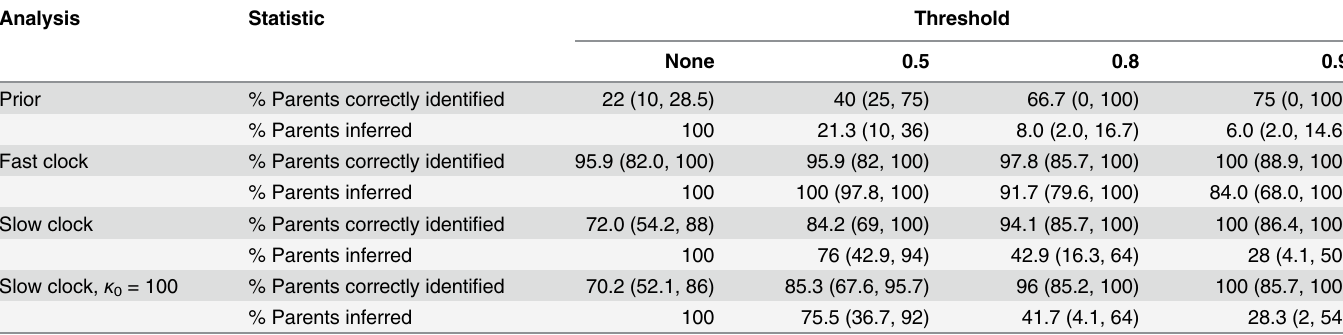
Table 4. Percentage of hosts with parents correctly identified by picking the infector host with the highest posterior probability for different thresh- olds, and percentage of hosts whose parents are inferred in this way for each threshold. Numbers are median and range across the 25